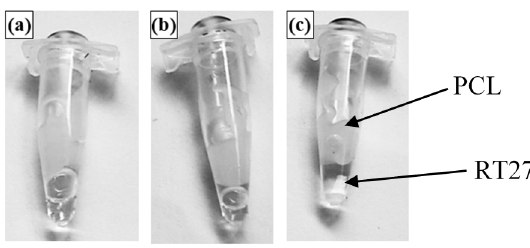
Figure 7. Migration of RT27 from PCL matrix, at 27 °C. ( a ) PCL/RT27_40% formulation ( b ) PCL/RT27_50% formulation ( c ) PCL/RT27_60% formulation.